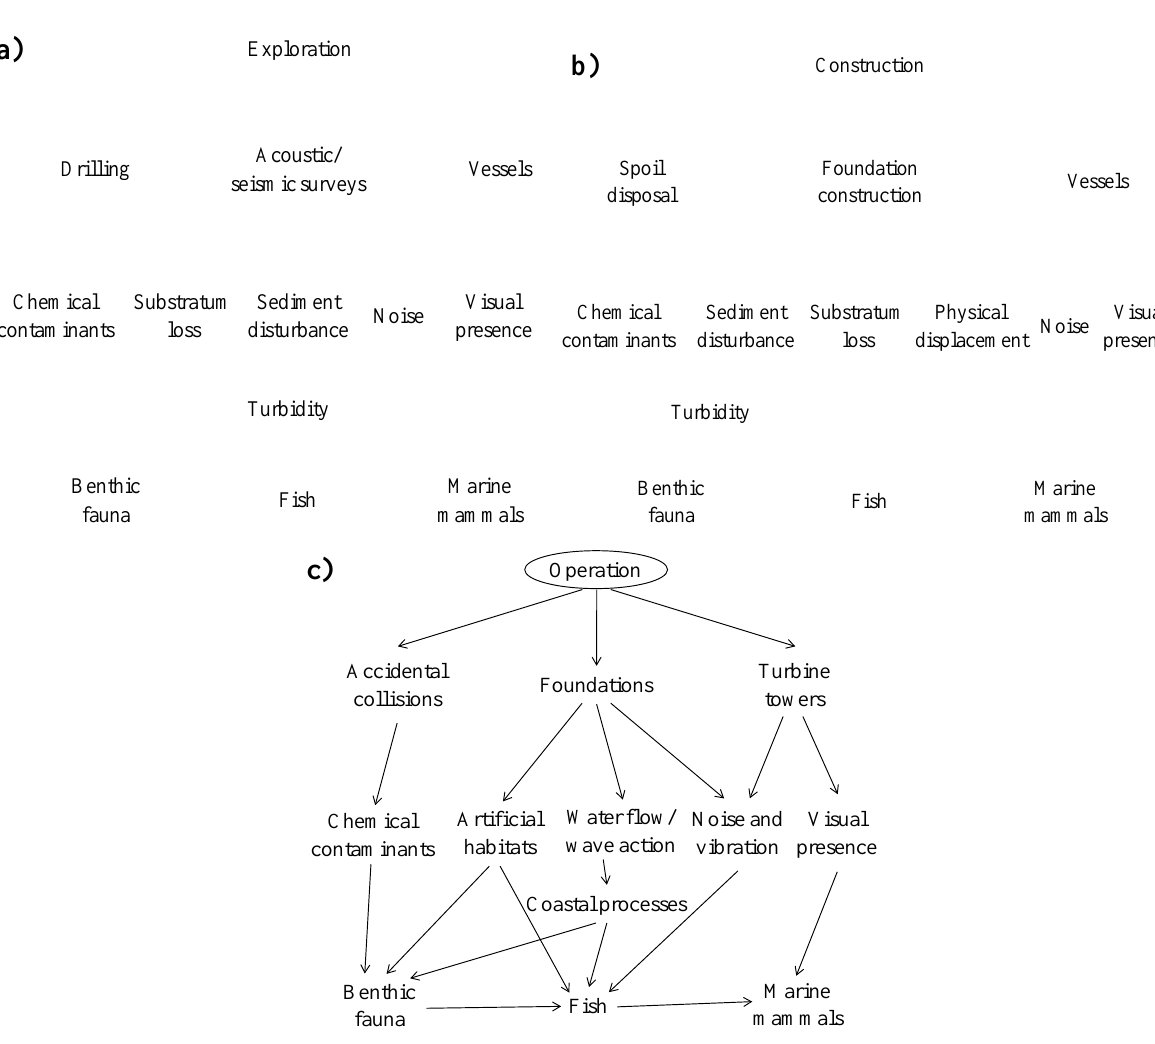
Figure 6. Environmental impacts of offshore wind farms during (a) pre-installation exploration, (b) construction (similar effects are likely to occur during decommissioning) and (c) operation (adapted from Gill [10]; Elliott